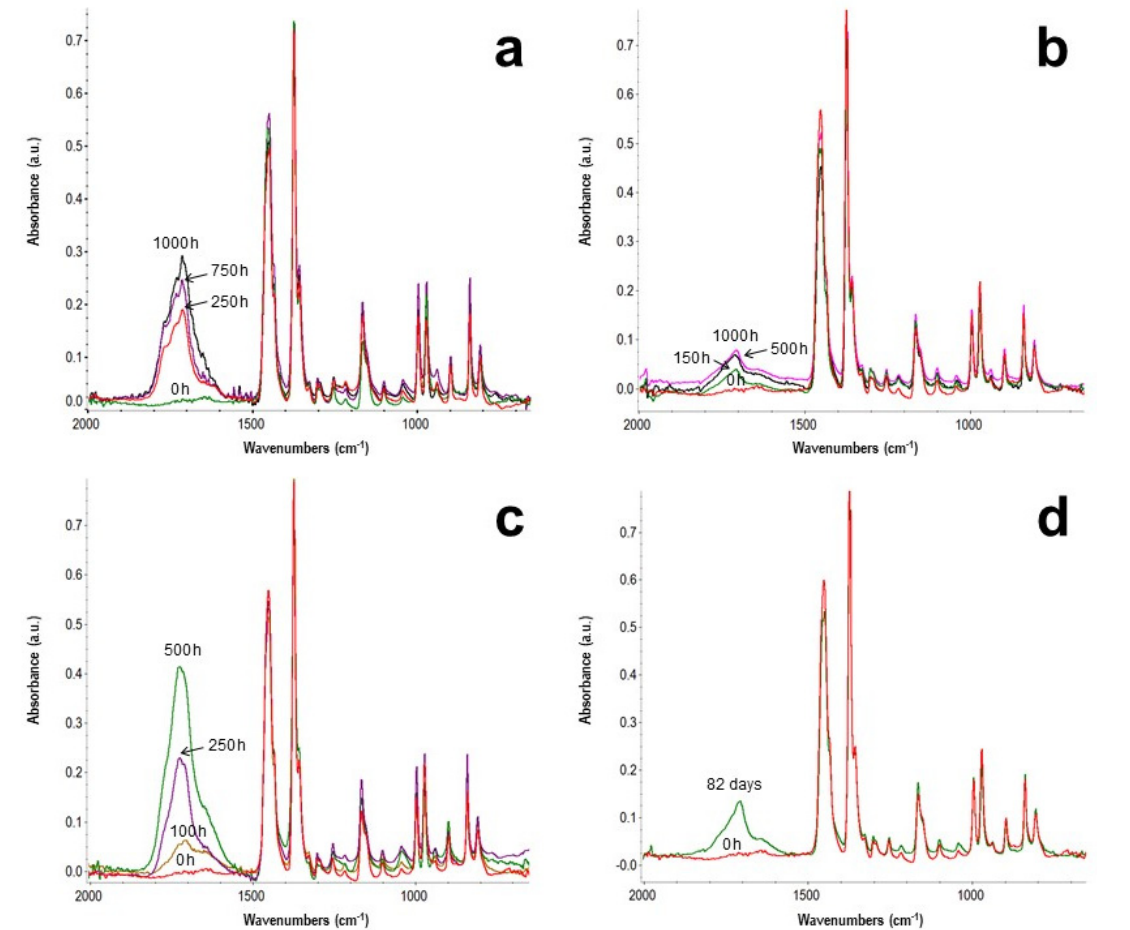
Figure 3. Selected ATR-FTIR spectra in the range 2000-670 cm − 1 of A1 exposed to isothermal aging at 110 °C ( a ), accelerated photoaging at 24 °C ( b ), accelerated photoaging at 44 °C ( c ), and outdoor aging ( d ).